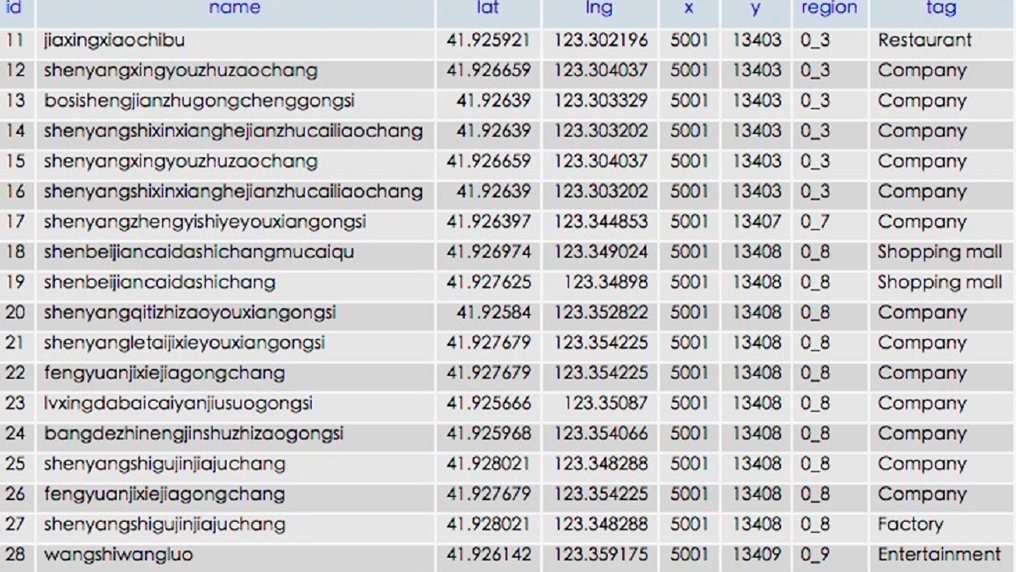
Figure 10. POI Samples in Shenyang.